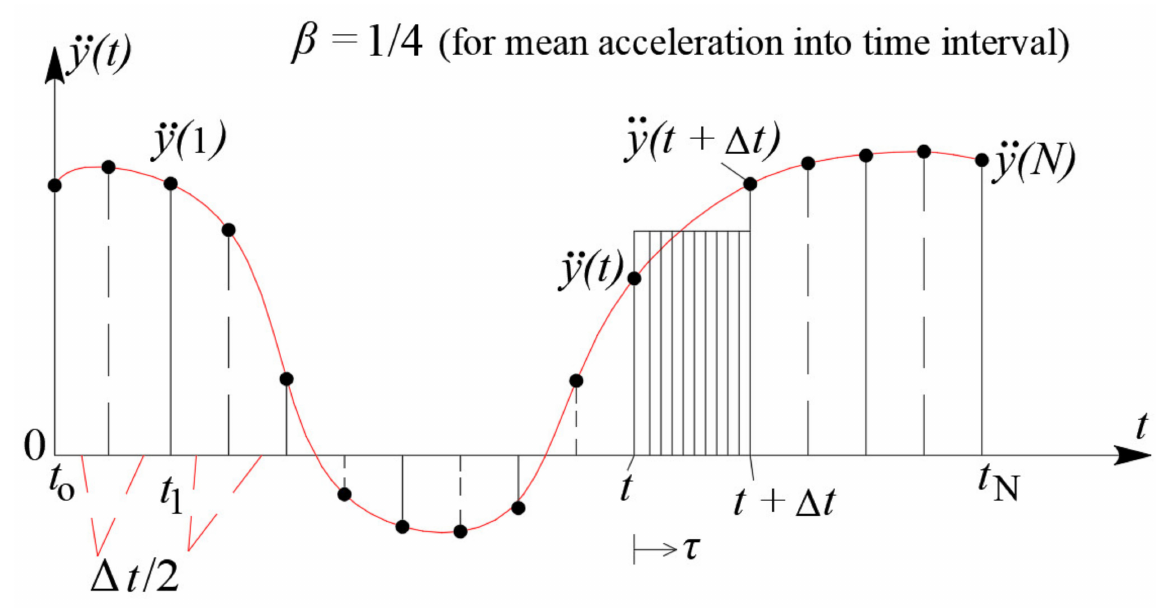
Figure 4. The change in acceleration between time t and t + ∆ t ( β = 0.25 for mean acceleration into each time interval, Chopra